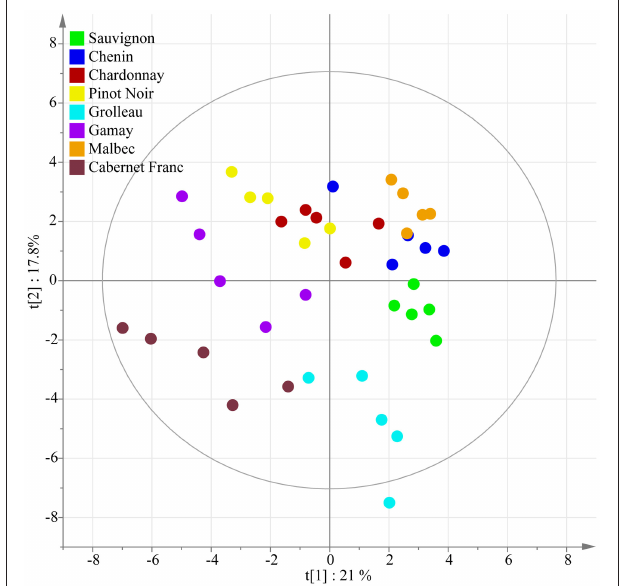
FIGURE 3 | Unsupervised classification using PCA. Score plot on polyphenol data from grape stems of eight genotypes in 2013. Variables in plot were colored according to the